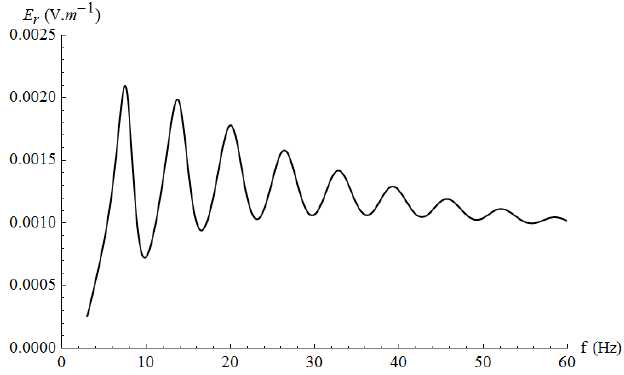
Figure 12: Electric field versus frequency at a distance of 1000 km from the source.